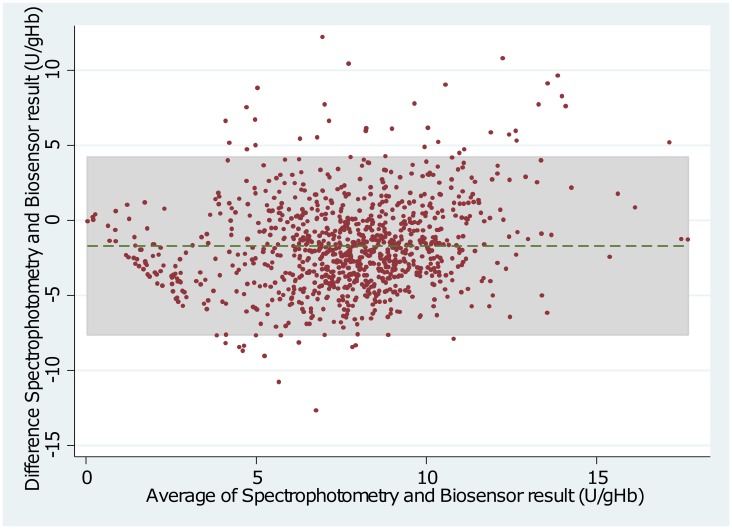
Bland—Altman Plot of Spectrophotometry and Biosensor.Dotted line indicates mean difference, grey shaded area indicates 95% limits of agreement.